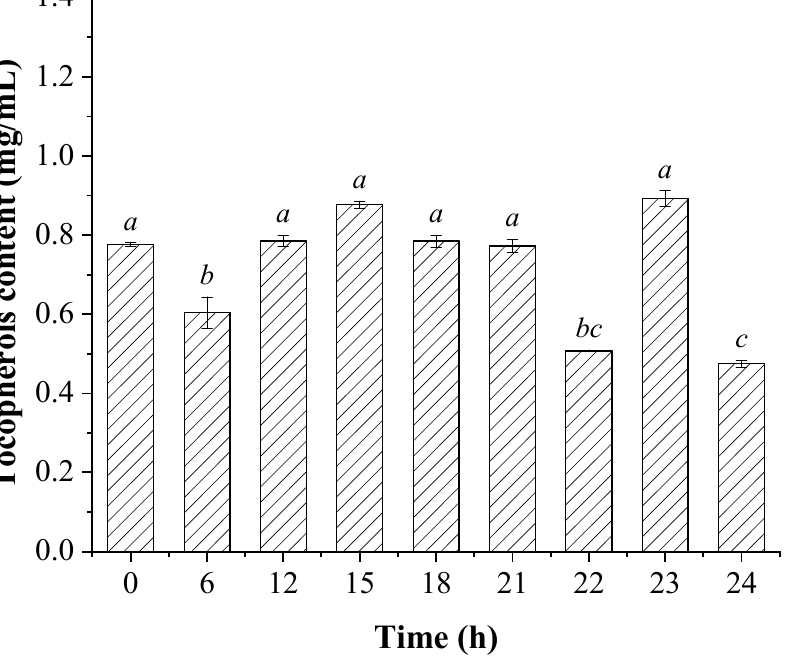
Figure 3. The tocopherols content in the soybean oils pretreated with visible light exposure prior to activated clay bleaching. Mean values with different letters over the bars indicate significant differences under p < 0.05 according to Tukey post-tests.